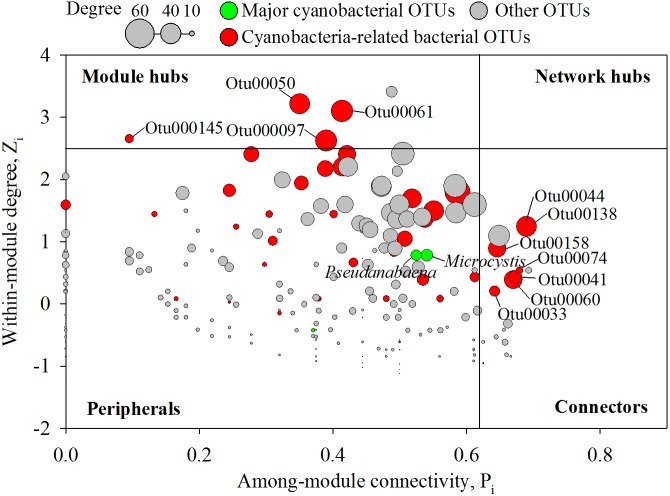
Zi–Pi plot showing the distribution of nodes based on their topological roles in the networks. Colors represent cyanobacterial OTUs and cyanobacteria-related bacterial OTUs. The threshold values of Zi and Pi for categorizing OTUs were 2.5 and 0.62, respectively, as simplified by Olesen et al. (2007).